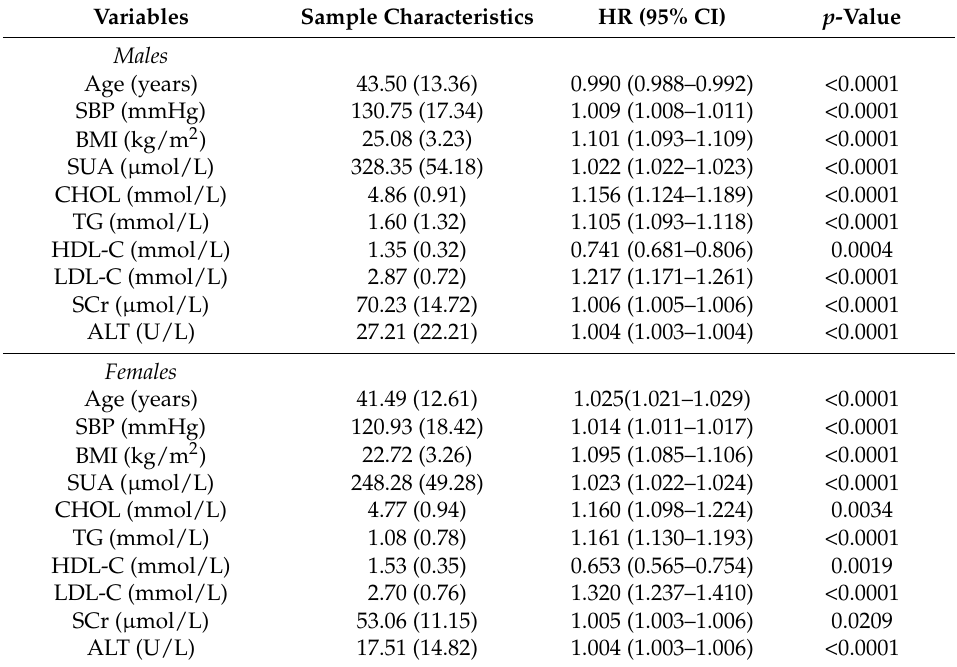
Table 2. Sample characteristics and Cox proportional hazards model (adjusted for age) for three-year risk of